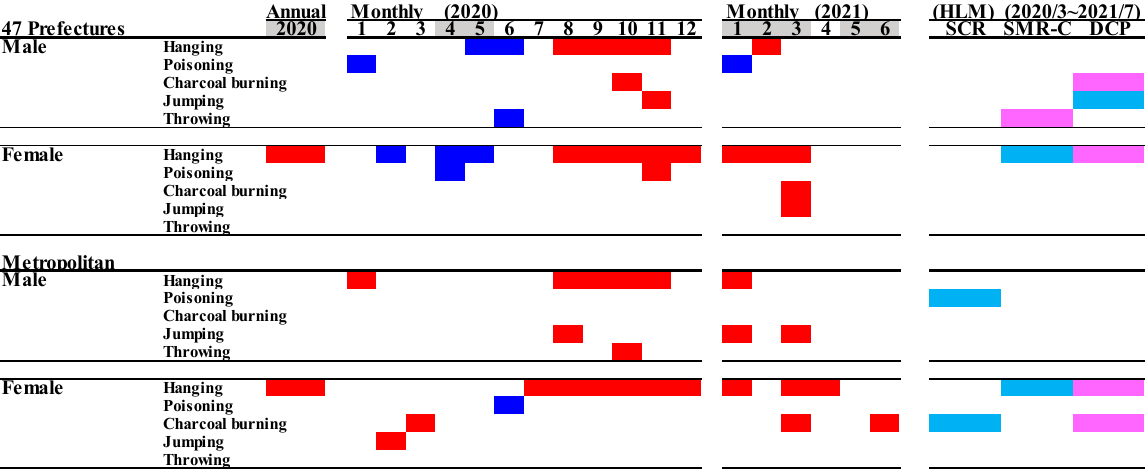
Figure 9. Comparison of annual and monthly SMR-S disaggregated by suicide means during the pandemic period to average SMR-S of the same month during pre-pandemic period, and impact of COVID-19 pandemic on SMR-S in Japan. Blue and red columns indicate significant decreasing and increasing suicide mortality using a linear mixed-effects model with Tukey’s multiple comparison ( p < 0.05). Light blue and red columns indicate significant decreasing and increasing factors against SMR-S using hierarchical linear model with robust standard error ( p < 0.05). SMR-S: standardised suicide mortality per 100,000 people. SCR: standardised infection with COVID-19 per 100,000 people. SMR-C: standardised mortality caused by COVID-19 per 100,000 people. DCP: during COVID-19 pandemic.